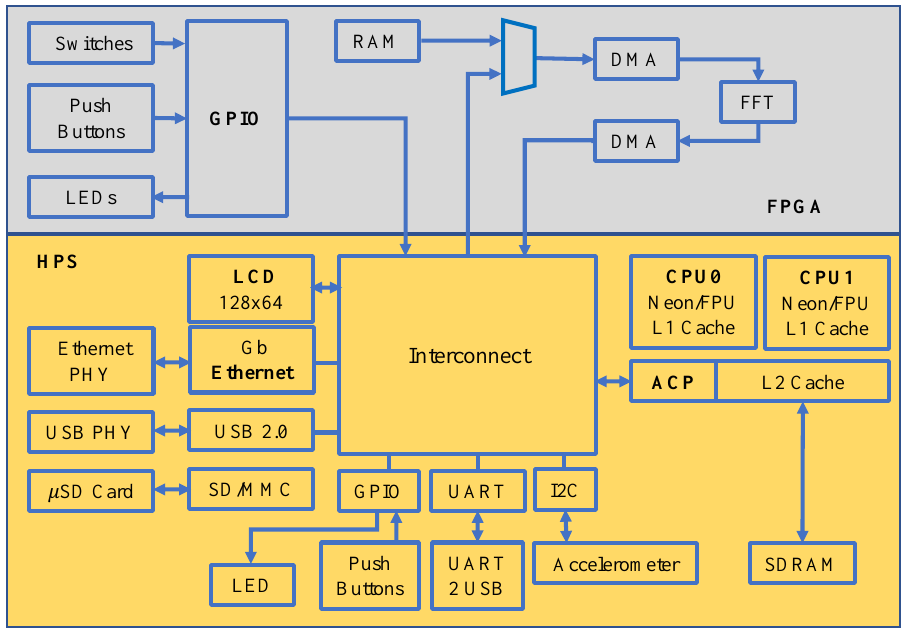
Figure 2. The SoCKit functional diagram consists of two main parts: the basic FPGA module and a Hard Processor System (HPS). Main modules include the Floating Point Unit (FPU), Accelerator Coherency Port (ACP), Secure Digital MultiMedia Card (SD/MMC), and Direct Memory Access (DMA).